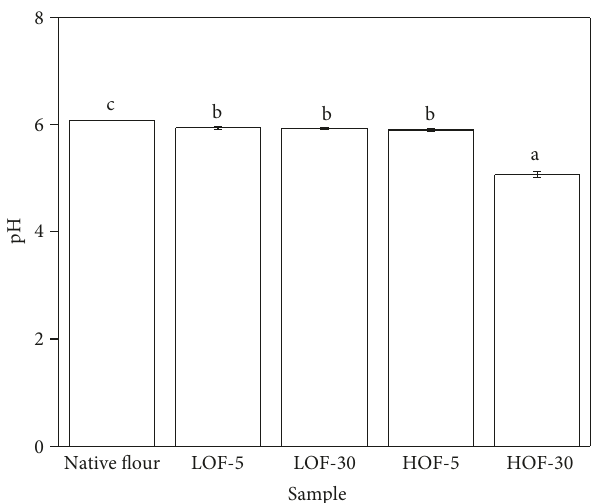
Figure 1: pH values of native and ozone-treated wheat flours. Means with the same letter were not significantly different ( α � 0.05). LOF-5: wheat flour treated at low-intensity condition for 5min; LOF-30: wheat flour treated at low-intensity condition for 30min; HOF-5: wheat flour treated at high-intensity condition for 5min; HOF-30: wheat flour treated at high-intensity condition for 30min.